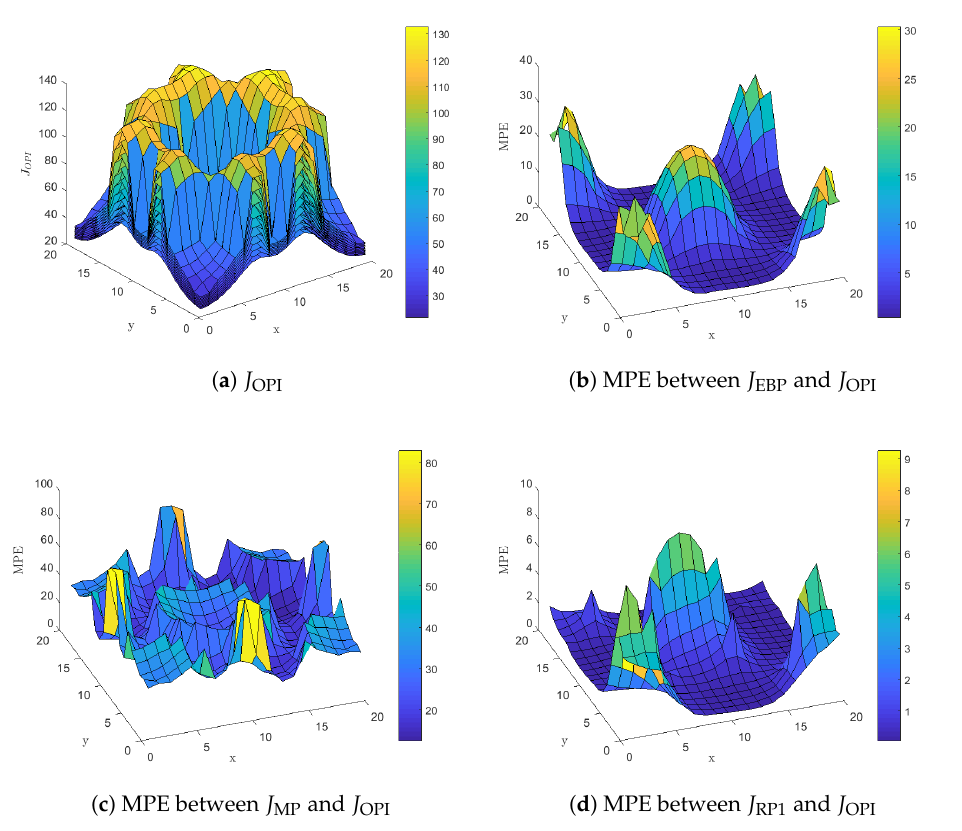
Figure 3. Mean Percentage Error (MPE) in energy consumption for each suboptimal policy compared to the horizon discounted cost for the Optimistic Policy Iteration (OPI) policy J OPI